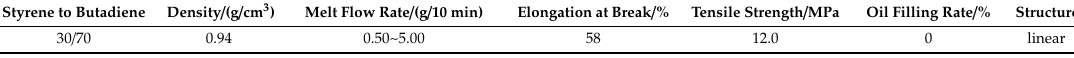
Table 2. Basic performances of YH791.